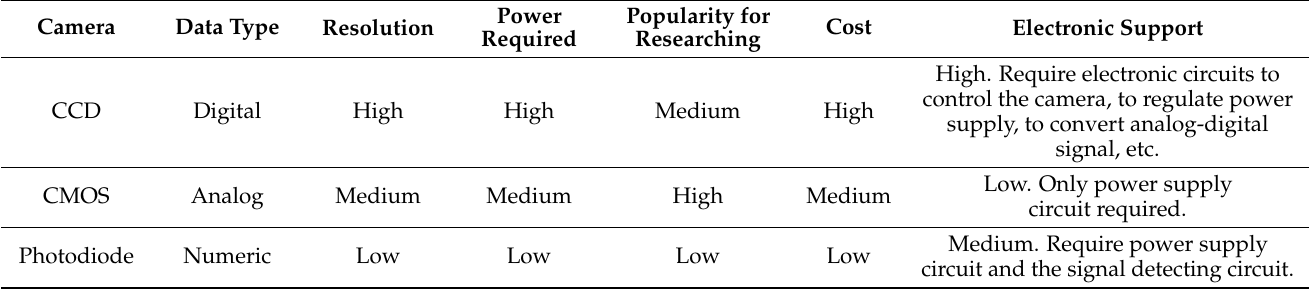
Table 3. Comparison of the pros and cons of CCD and CMOS cameras and a photodiode.